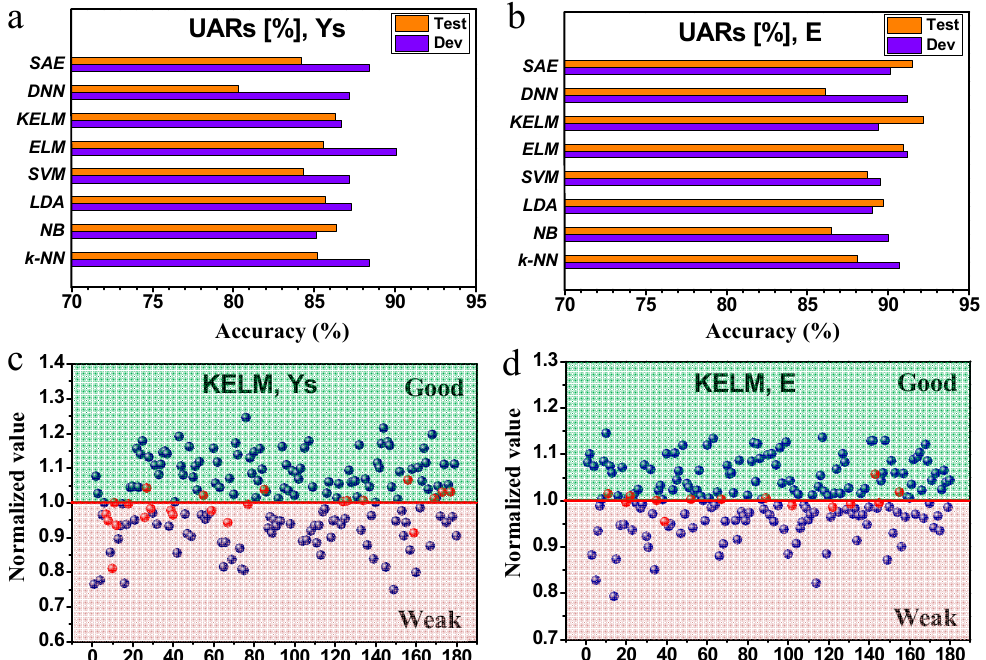
Figure 6. Results of ML models training and evaluation. The results (UARs in [%]) of eight ML models on the task of ( a ) yield stress, and ( b ) Young’s modulus. The UARs shown for the dev set are the best UARs achieved by the optimal hyper- parameters tuned for the corresponding model. The UARs shown for the test set are the final performance achieved by the model trained by the train plus dev sets within the optimal hyper-parameters. Prediction result of the 180 non-equiatomic samples on the test set by KELM model for ( c ) yield stress, and ( d ) Young’s modulus. The red line is the benchmark line based on the value of the equiatomic sample, the results of non-equiatomic samples are normalised to the benchmark value, where the values above the line are classified to the ‘Good’ zone, and those below the line are classified to the ‘Weak’ zone. If the ML prediction matches the MD simulation, the point is coloured blue, but otherwise the point is coloured red.